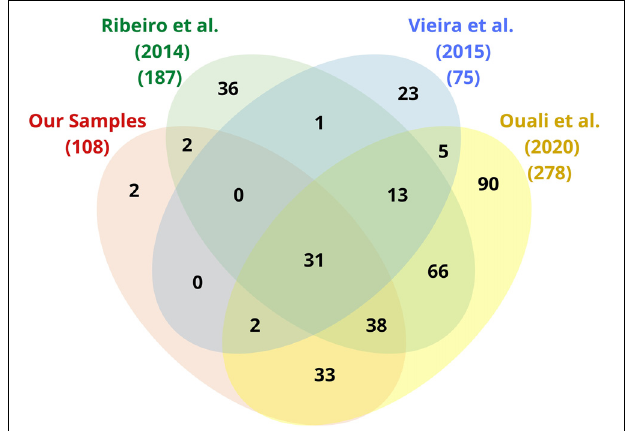
FIGURE 2 | Venn diagram (Interactivenn) of complete EC annotations from our samples and those of Ribeiro et al. (2014), Vieira et al. (2015), and Ouali et al. (2020). The total number of enzyme functions (ECs) is indicated beside each